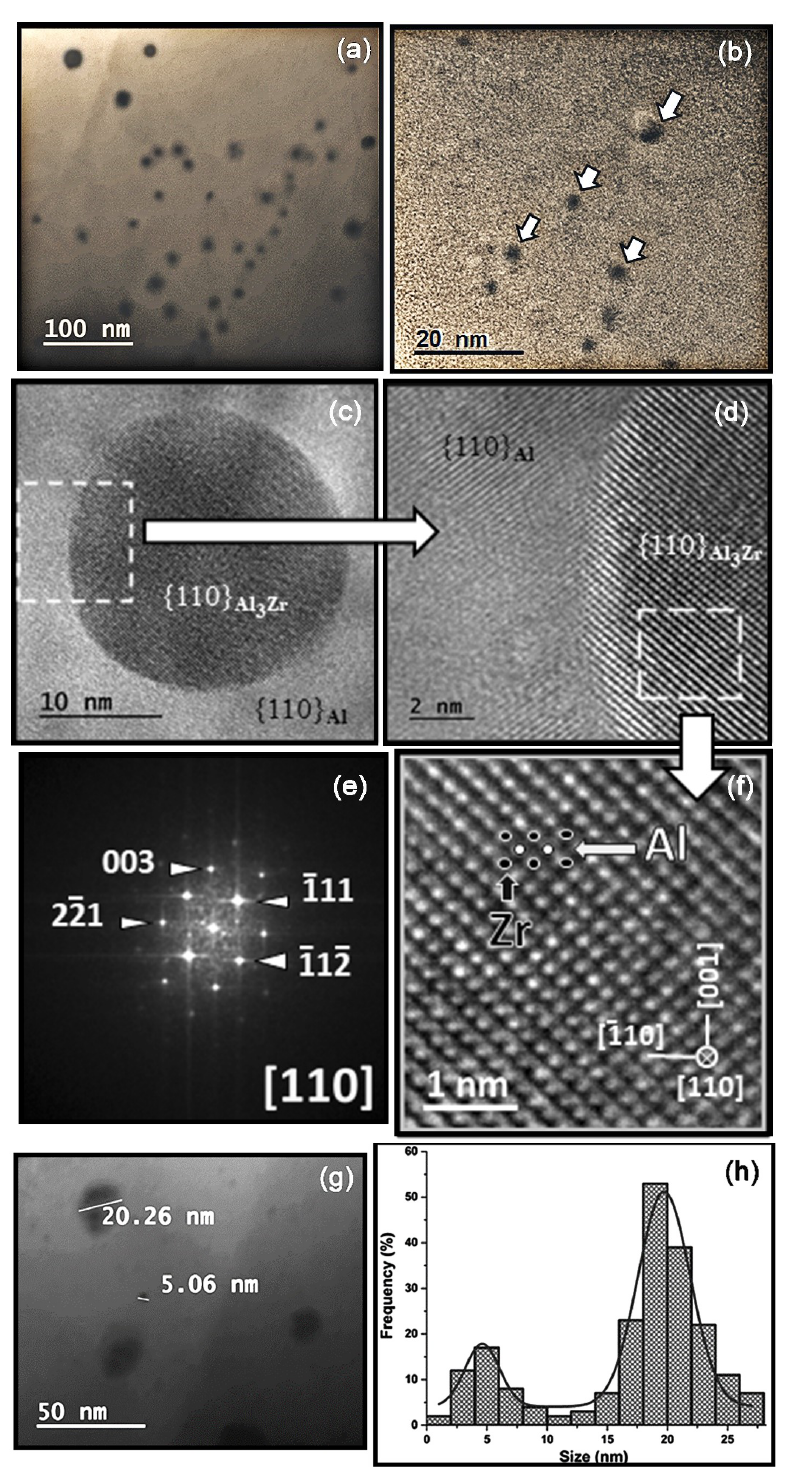
Figure 6. Alloy-II aged at 400 °C for 900 h. ( a , b ) TEM images at different magnifications showing the size and morphology of the precipitates; ( c ) TEM image showing a nanometric precipitate of the metastable L1 2 -Al 3 Zr phase in (110) facet of the α(Al) matrix; ( d ) HRTEM image of the area enclosed by the dashed square in ( c ) showing the coherence of this nanosized precipitate of the